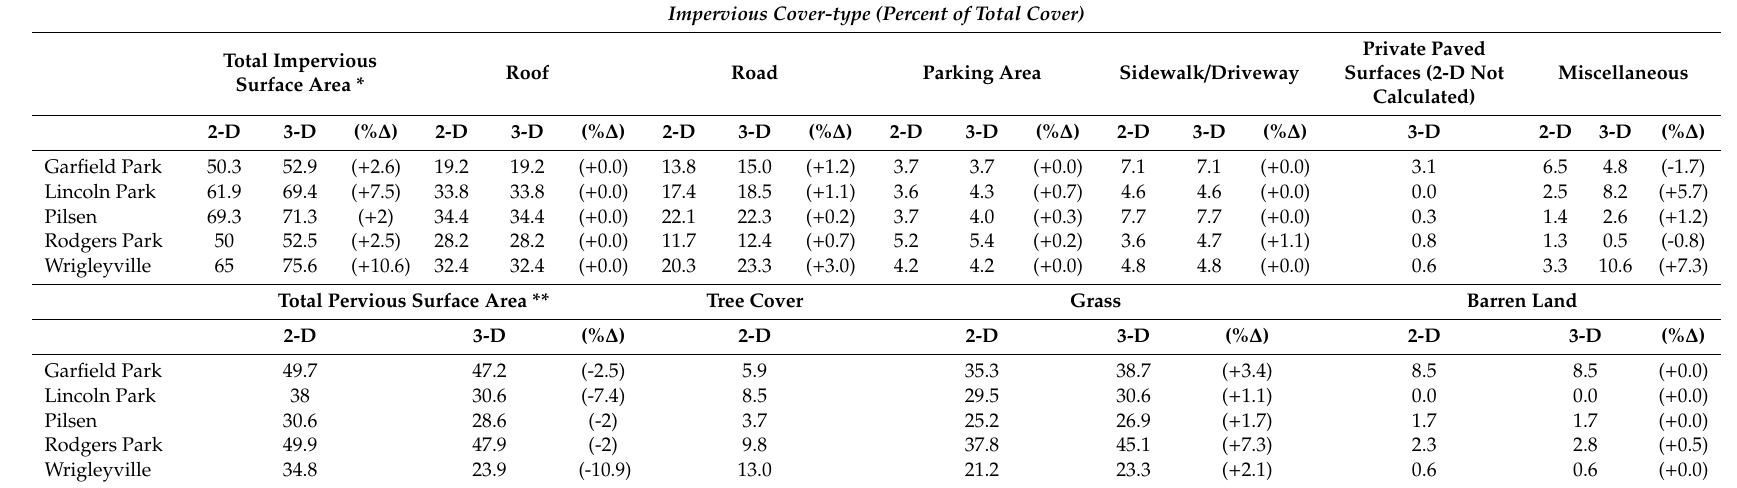
Table 4. Two and three-dimensional orthoimagery land cover analysis of five medium density Chicago neighborhoods in 2000 from Reference